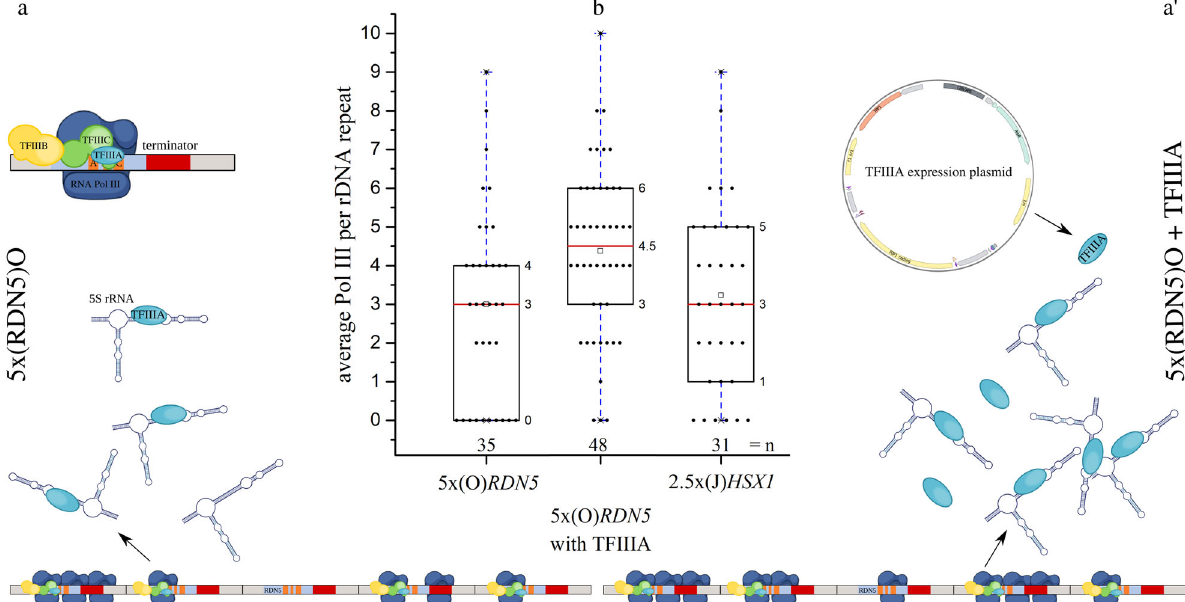
Fig. 4 Quantitative analysis of TFIIIA overexpression in 5x(O)RDN5. a, a ′ Schematic of RDN5 transcription regulation in strain 5x(O) RDN5 with and without TFIIIA overexpression. b Boxplot analysis of average number of Pol III complexes per rDNA repeat of 5x(O) RDN5 , 5x(O) RDN5 with TFIIIA overexpression and 2.5x(J) HSX1 . Box = 25 – 75%, bracket = range within 1.5 IQR, red horizontal line = median, square = mean, diamonds = outliers, dots = individual data points. The number of analyzed well-spread Miller tree pairs per strain is indicated below the boxes (Supplementary Table 5). Images of two independent preparations of chromatin for each strain were included in the